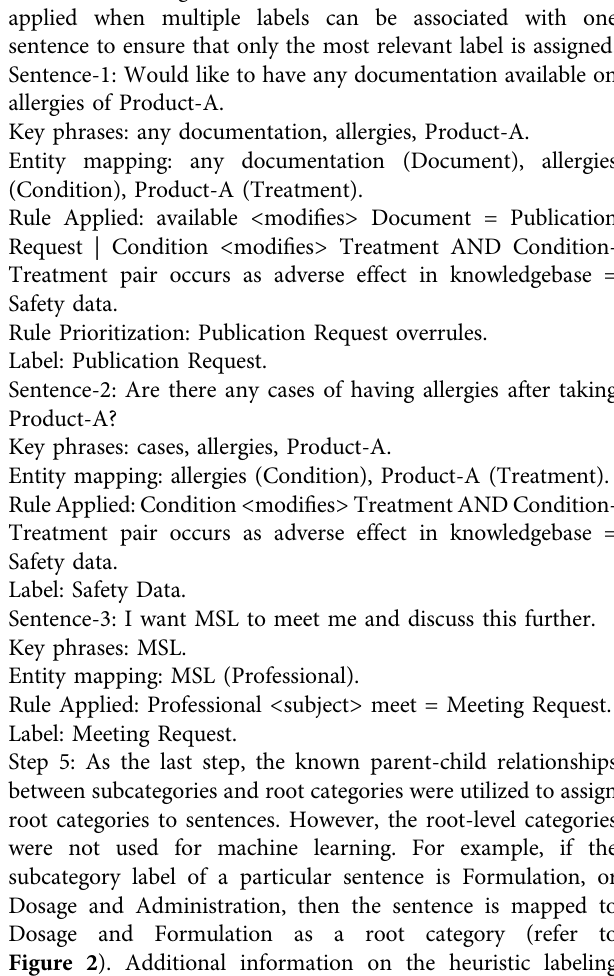
Frontiers in Research Metrics and Analytics |